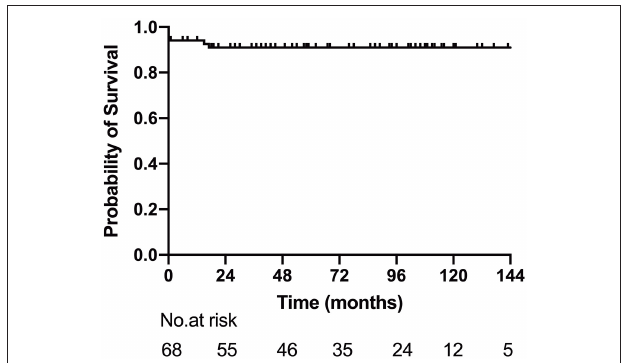
FIGURE 3 | Survival for patients after Glenn shunt.